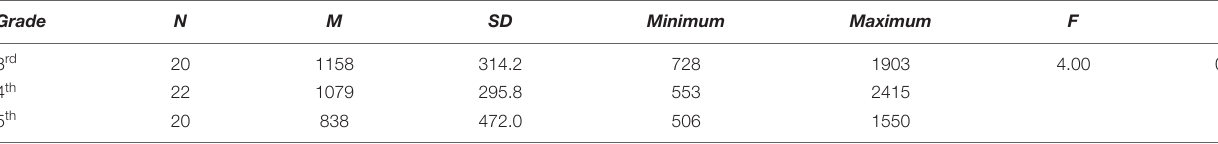
TABLE 4 | Gaze duration (ms): descriptive statistics and comparison within grades.